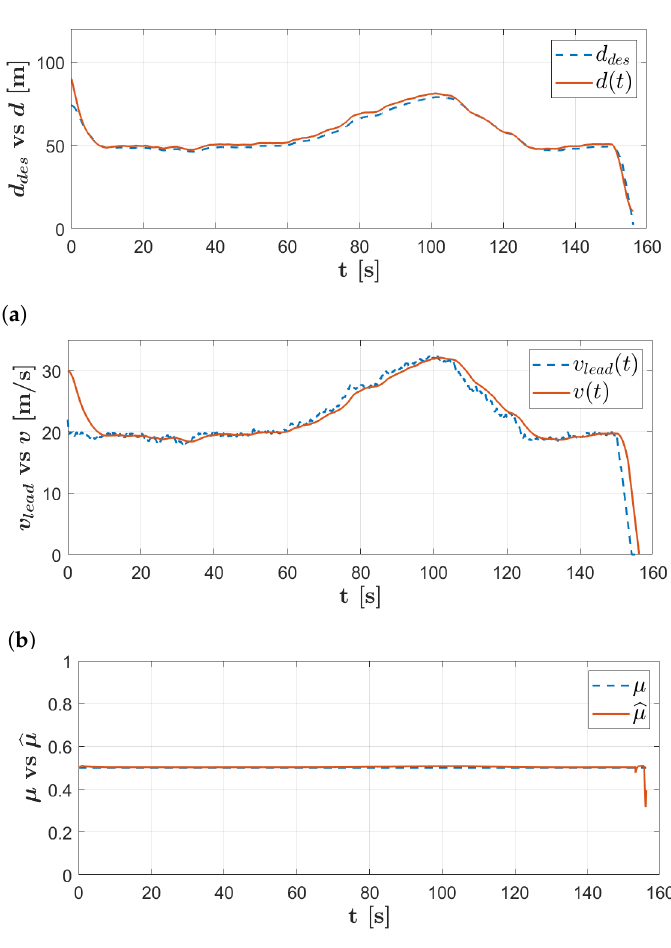
Figure 7. Road-Grip aware Driving Functionalities: vehicle-following and hard emergency braking. ( a ) Time-history of the current distance gap, d , and of the desired one, d des . ( b ) Time-history of the ego velocity v and leader velocity v lead . ( c ) On-board road-grip estimate, µ ( t ) vs. (cid:98) µ .